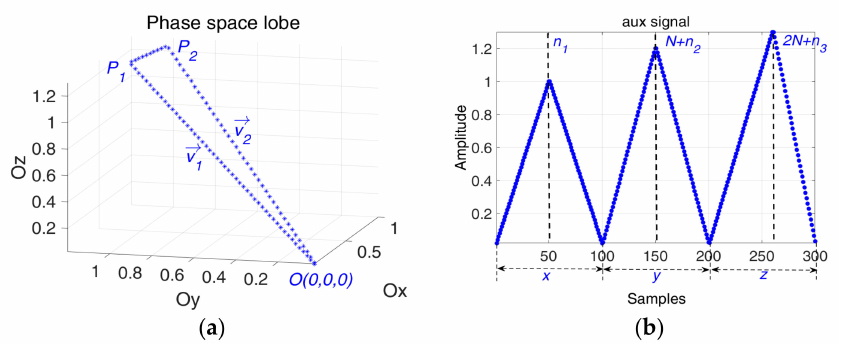
Figure 3. ( a ) The generated phase space lobe; ( b ) The corresponding aux signal based on Equations (5) and (7) with the following parameters: N = 100 , a 1 = 1, b 1 = 1.2, c 1 = 1.3, n 1 = 50, n 2 = 50, n 3 = 60.